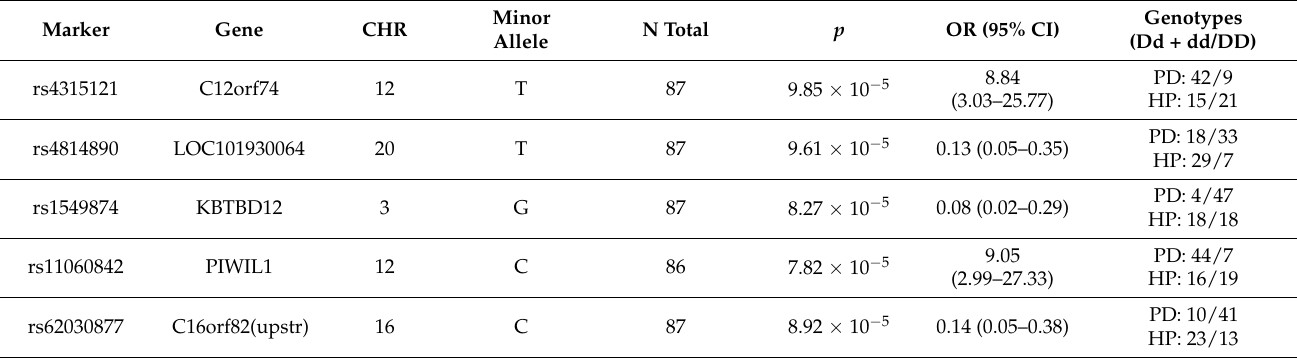
Table 1. Results of individual (SNP by SNP) logistic regression analysis for the top associated SNPs adjusting for covariates. Marker Gene